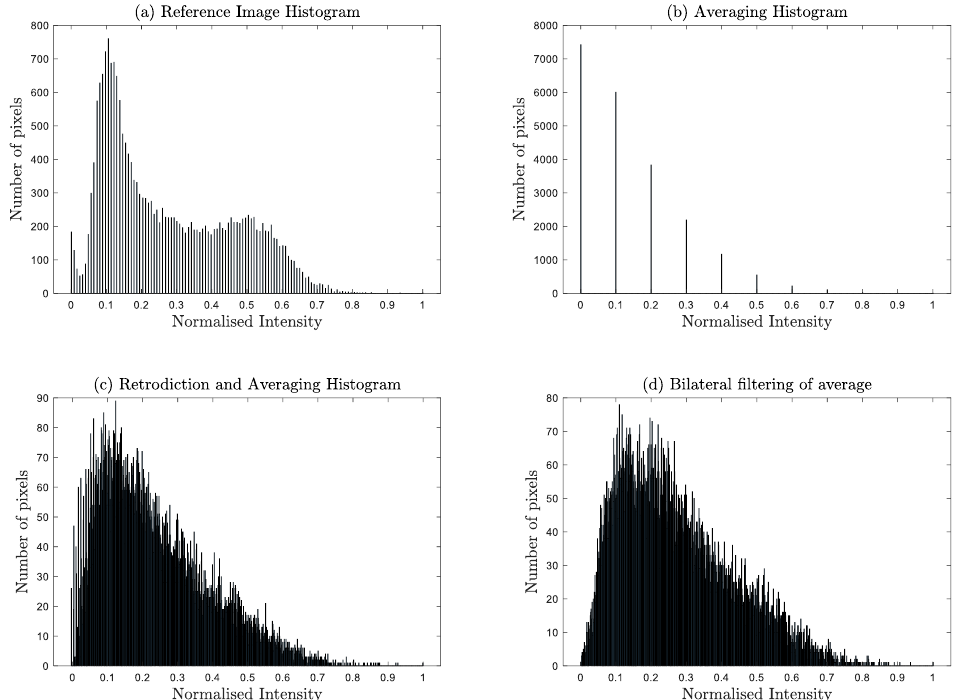
Figure 10. 1000 bin histograms of ( a ) the reference image shown in Figure 2a, ( b ) the averaging, ( c ) retrodiction and averaging, and ( d ) bilateral filtering methods for 2 µ s total exposure time images shown in Figure